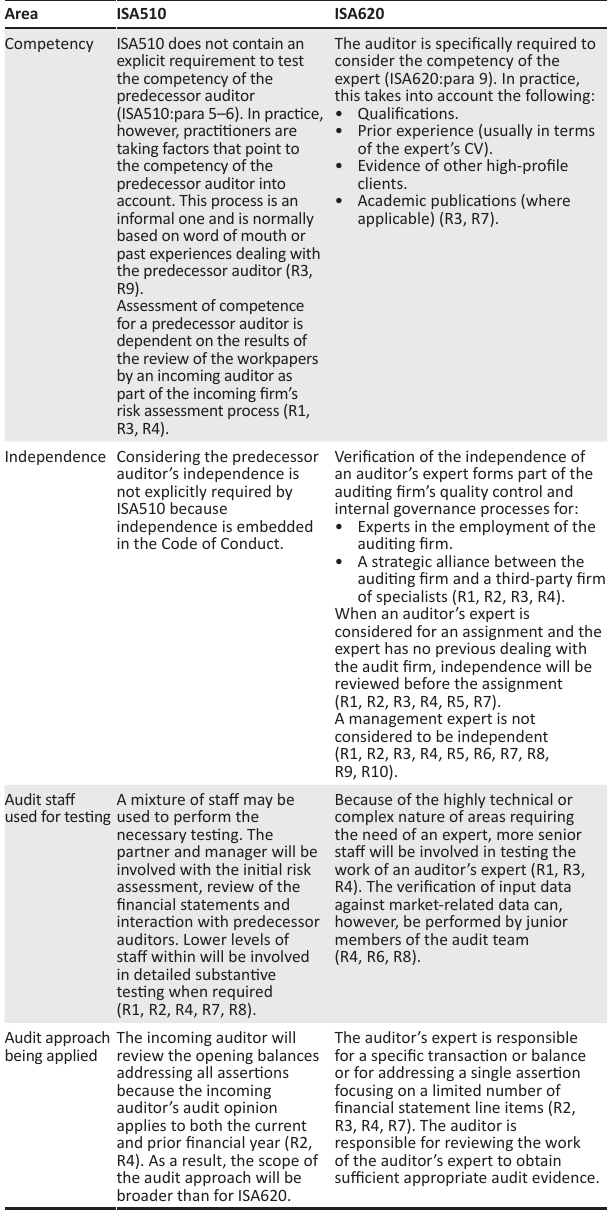
TABLE 2 : Similarities and tensions between ISA510 and